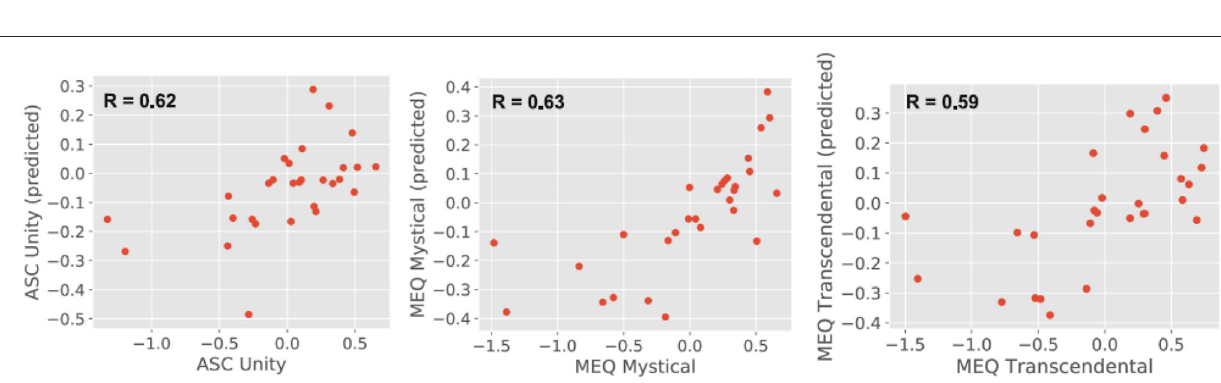
trait anxiety (STAI), and trait absorption (TAS). Consistent with a previous survey study (25), we only found significant correlations with trait absorption ( R = 0.43 for 5D-ASC Unity and R = 0.51 for MEQ30